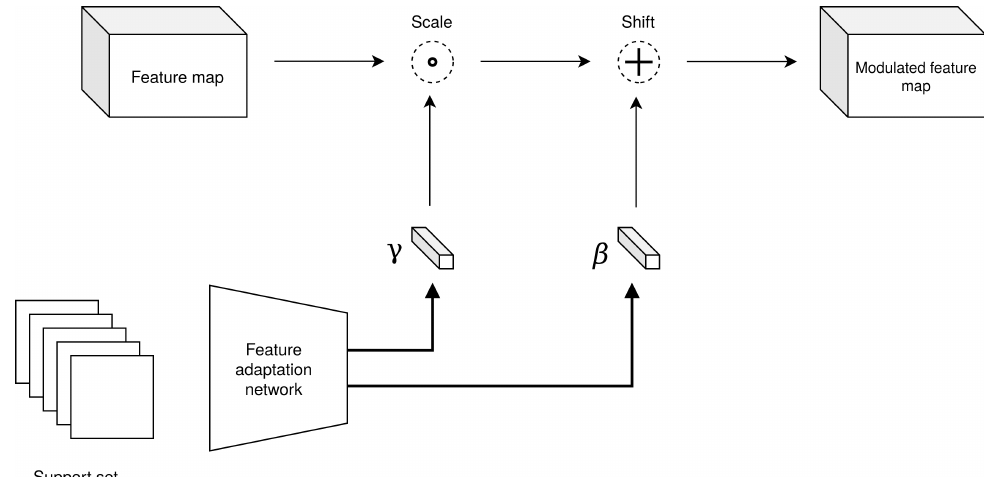
Figure 7. Principle of a FiLM layer applied to few-shot learning: the support set passes through a feature adaptation network, producing γ and β parameters that will respectively scale (the dot represents the Hadamard product, or channel-wise multiplication) and shift (the cross represents channel-wise addition) feature maps at different levels of a convolutional neural